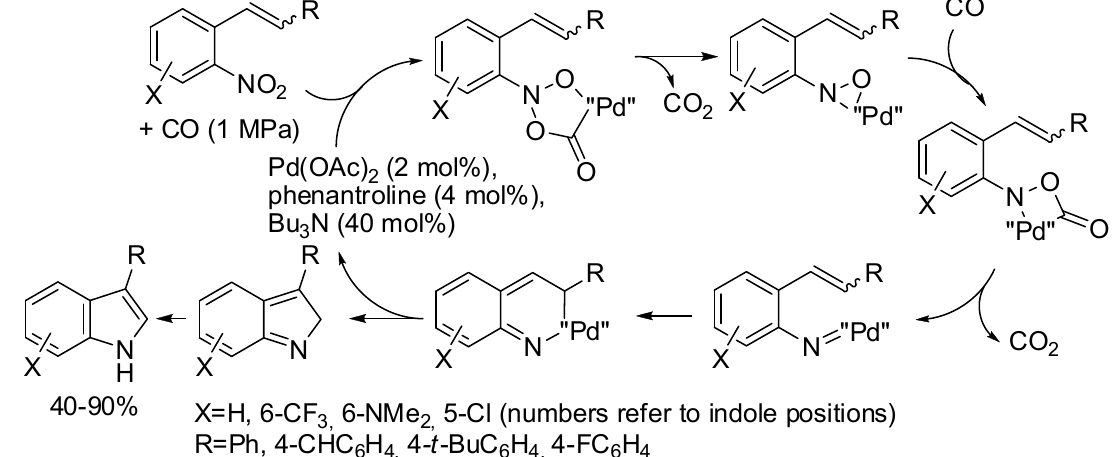
Scheme 38. Continuous flow synthesis of indoles by reduction of o -vinylnitroarenes.